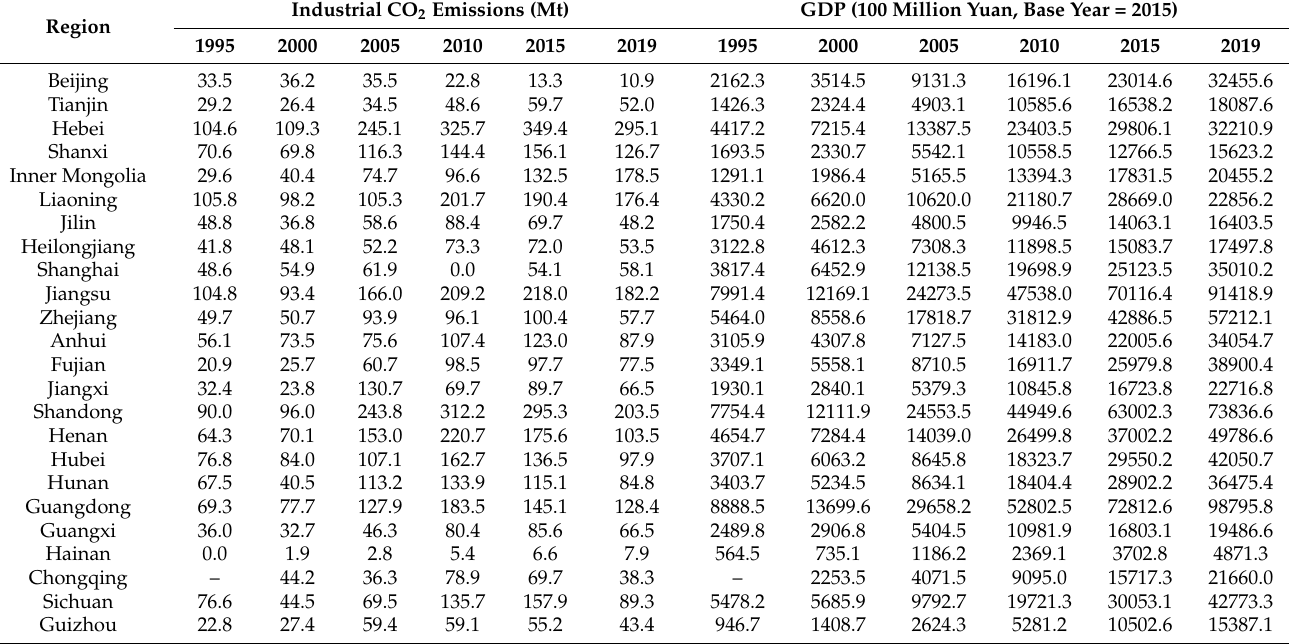
Table 3. The statistical description of industrial CO 2 emissions and GDP at the provincial level.